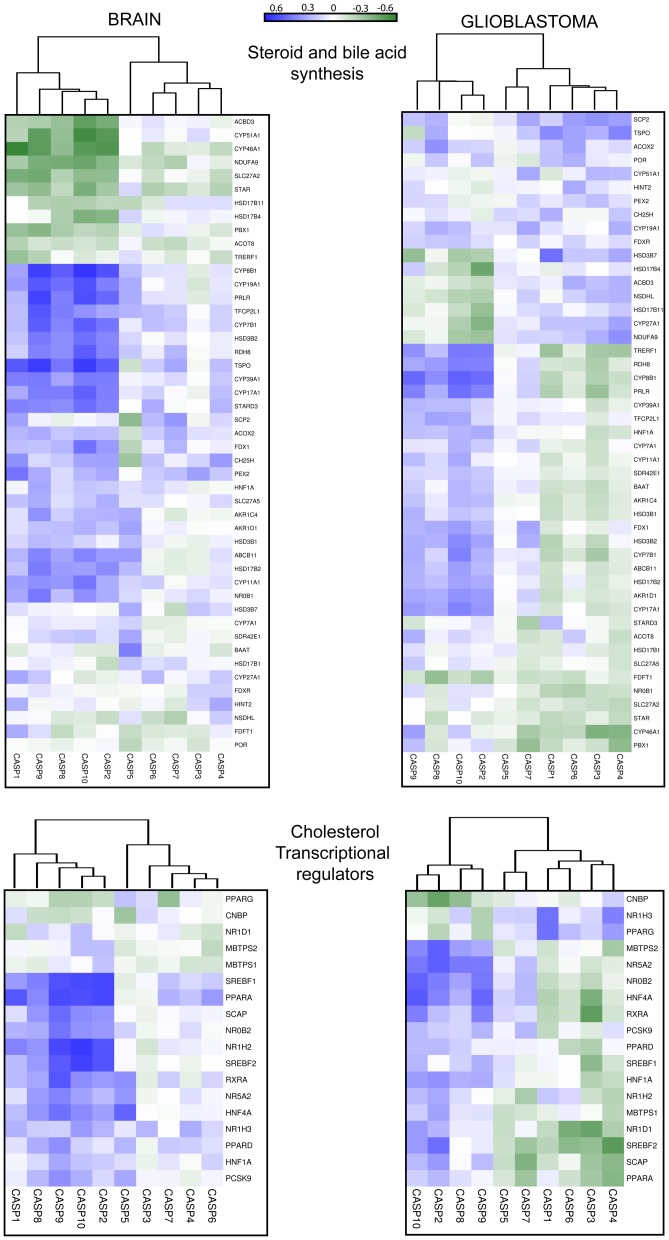
Co-expression analysis of caspases and cholesterol genes in human brain and GBM.Correlations of expression levels between caspases and cholesterol genes in different brain and GBM samples, for the indicated categories. Data obtained were used to calculate the correlation values with the Pearson method. In the heat map positive values are displayed in blue and negative in dark green. The dendrograms displayed on the top are based on hierarchical clustering using the complete linkage method.